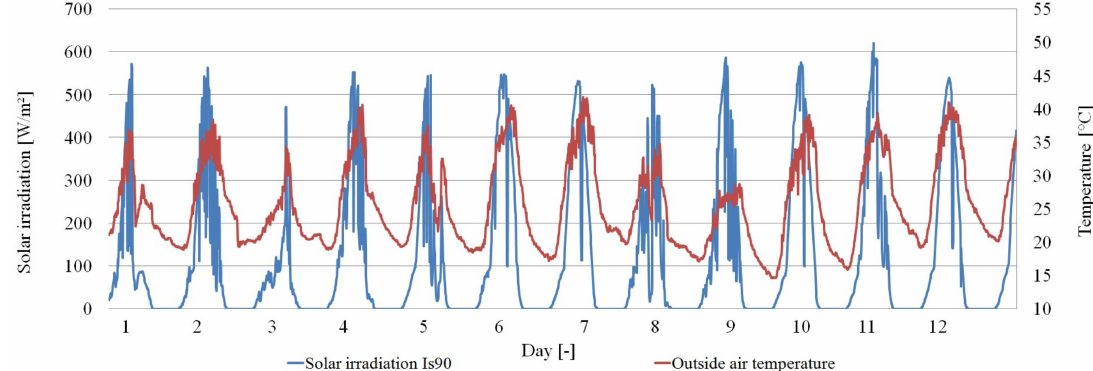
Figure 7. Graph of the intensity of solar radiation on the S90 surfaces and the temperature of the outside air.